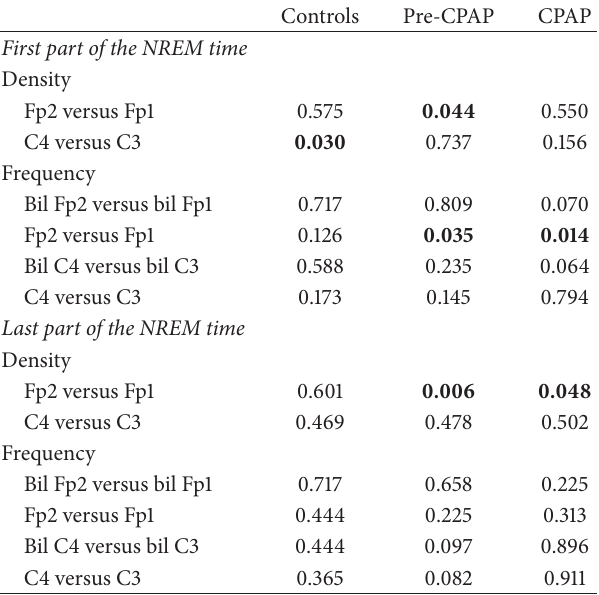
Table 3: 𝑝 values of the hemispheric right-left comparisons of the bilateral and unilateral spindle frequencies and unilateral densities in the different study groups.